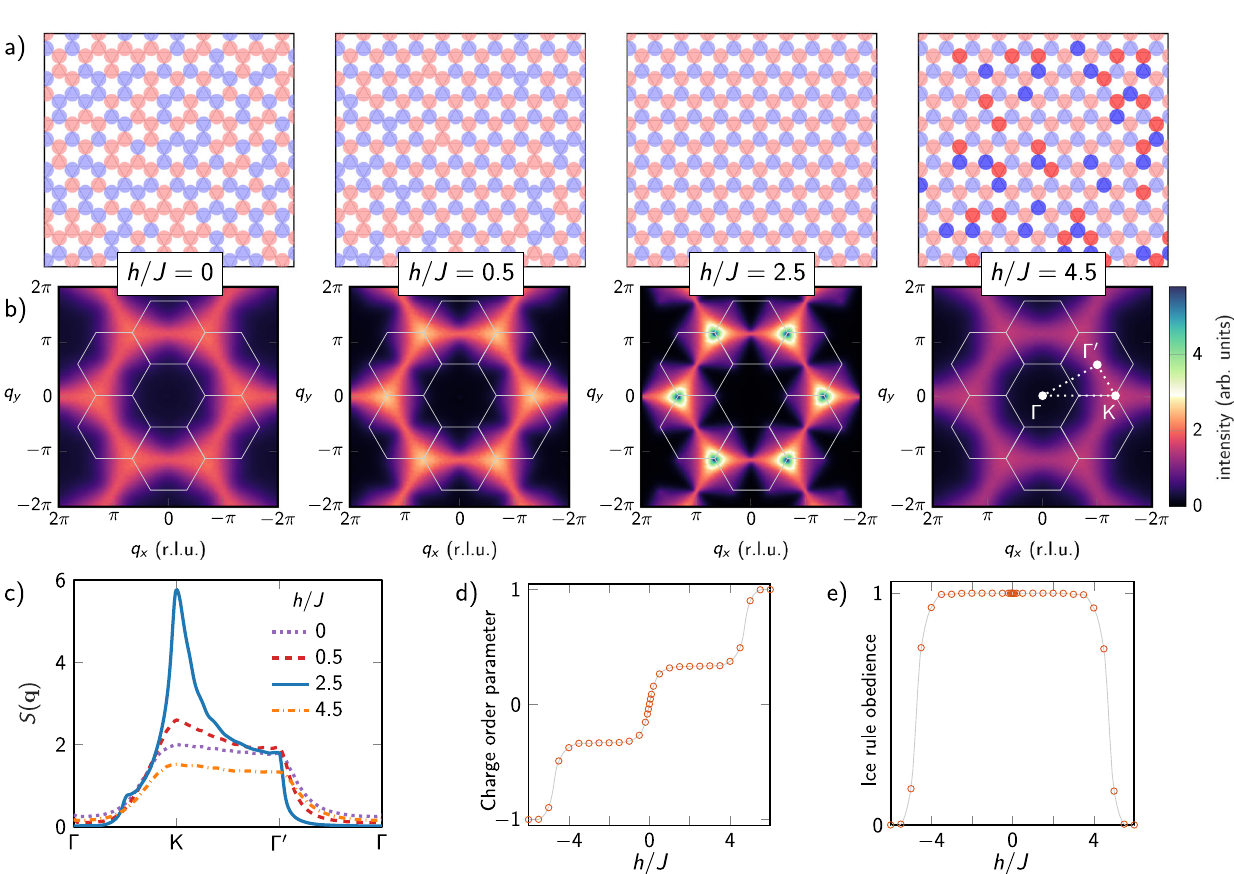
Fig. 3 | Field-induced charge phases and qubit ice structure. a Charge states for varying external fi eld h . At h =0, vertices have no energetic preferencebetween − 1 and +1 charge (light blue and red respectively), leading to charge disorder. As h increases, A and B vertices energetically favor − 1 and +1 charges, respectively, leading to long-range order in the staggered charge. Eventually, h polarizes the sites, leading to a preponderance of − 3 and +3chargedvertices (dark blue and red